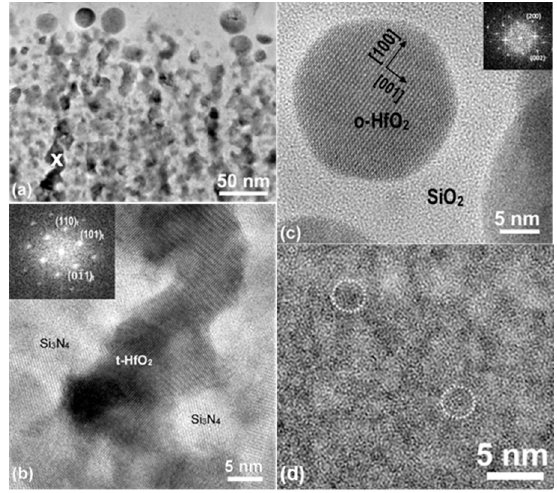
Figure 3. ( a ) Zoom-in cross-section TEM of the transition layer of the annealed Hf 6 B 10 Si 31 C 2 N 50 film. HRTEM taken from the ( b ) transition layer shown in ( a ), ( c ) top oxide layer and ( d ) amorphous layer shown in Figure 2a. The circles indicate sub nanometer ordered structures.